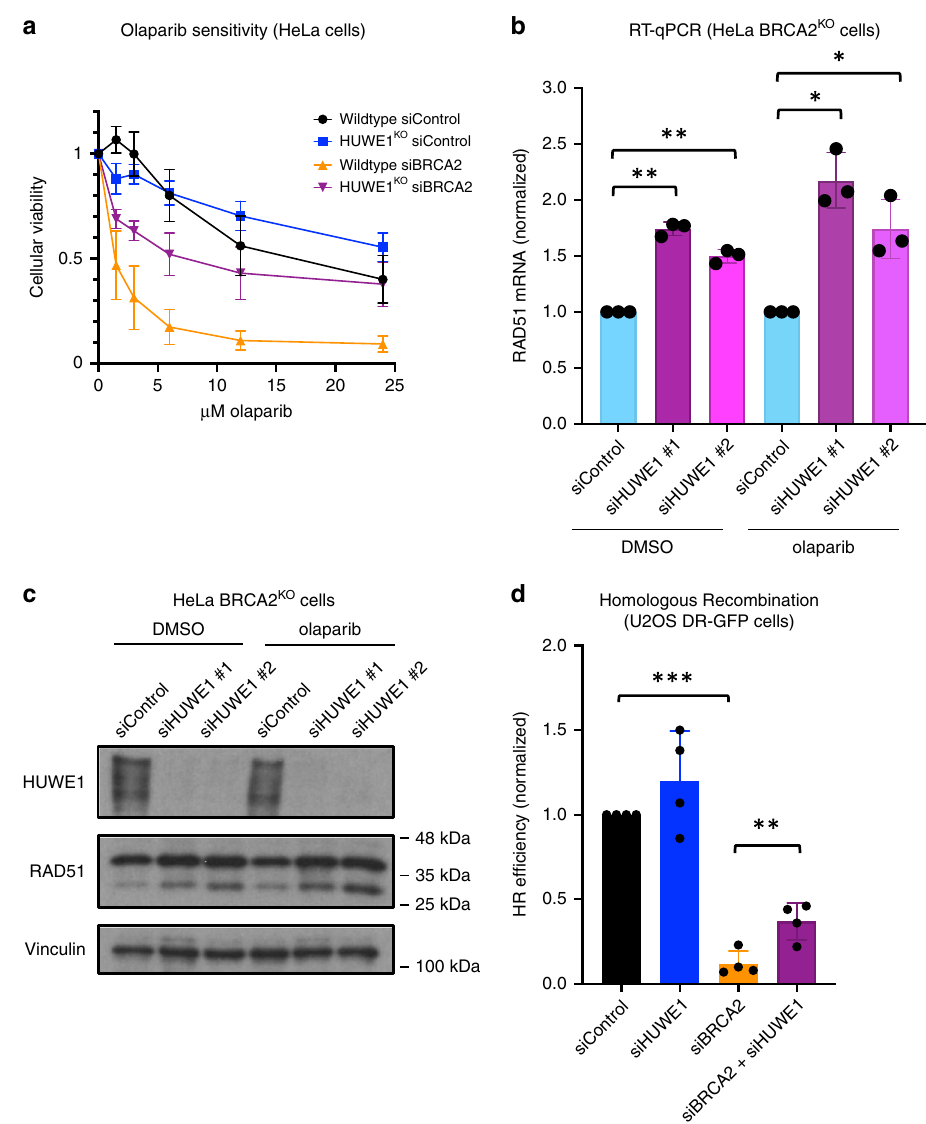
Fig. 4 Loss of HUWE1 results in increased RAD51 levels and partial restoration of homologous recombination in BRCA2-de fi cient cells. a Knockout of HUWE1 rescues the olaparib sensitivity of BRCA2-depleted HeLa cells in cellular viability assays. The graph presents the average of three experiments performed after 72 h of treatment, with standard deviations shown as error bars. b Quantitative PCR assay showing that HUWE1 depletion increases RAD51 mRNA levels. Cells were treated with DMSO or 10 μ M olaparib for 24 h, as indicated. Data shown are the average of three experiments, normalized to the siControl condition, with standard deviations shown as error bars. Statistical signi fi cance is indicated by asterisks ( t -test, two-tailed, unequal variance). c Western blot of whole-cell extracts showing that HUWE1 knockdown increases RAD51 protein levels. Cells were treated with DMSO or 10 μ M olaparib for 24 h, as indicated. d HUWE1 depletion partially rescues the homologous recombination defect caused by BRCA2 knockdown as shown using a DR-GFP assay. The averages of four experiments are shown, with standard deviations as error bars. Statistical signi fi cance is indicated by asterisks ( t -test, two-tailed, unequal variance). Source data are provided as a Source Data fi